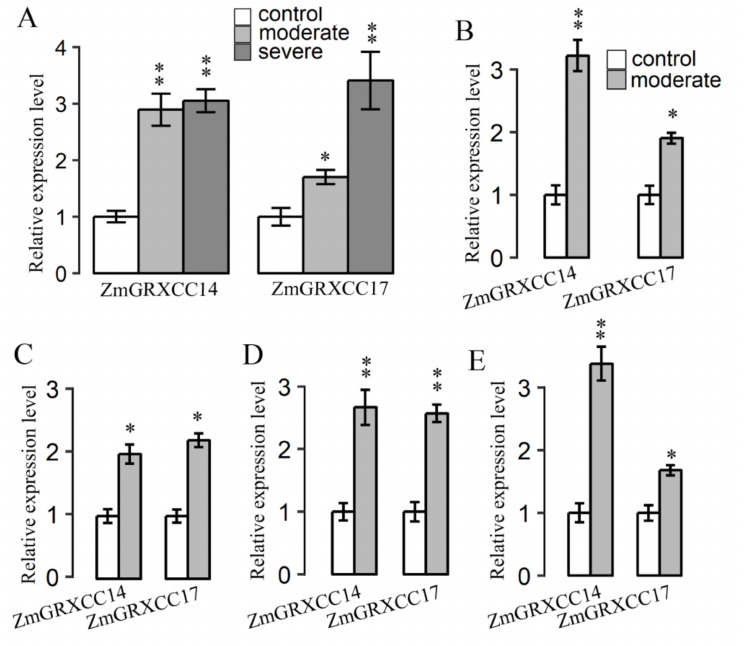
Figure 7. Expression patterns of ZmGRXCC14 and 17 in seedlings ( A ), V12 ( B ), V14 ( C ), V16 ( D ), and R1 ( E ) under drought. ZmUbi -2 was used as an internal control for data analysis. The mean and SD were calculated from data of three biological replicates. t -test, * p ≤ 0.05, ** p ≤